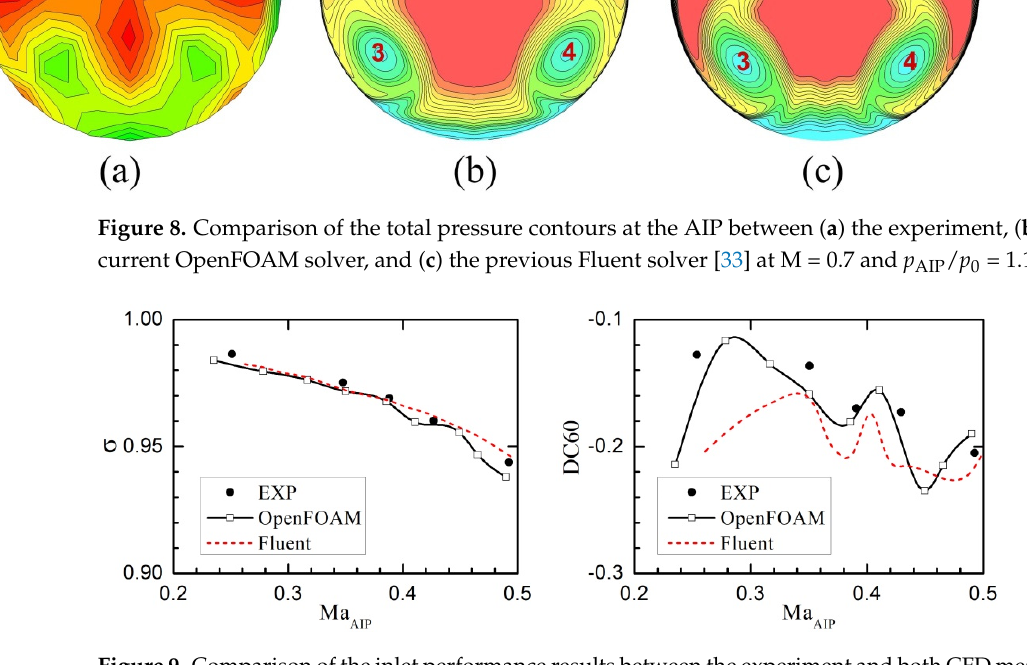
Figure 9. Comparison of the inlet performance results between the experiment and both CFD methods at various AIP Mach numbers (M = 0.7). at various AIP Mach numbers (M =